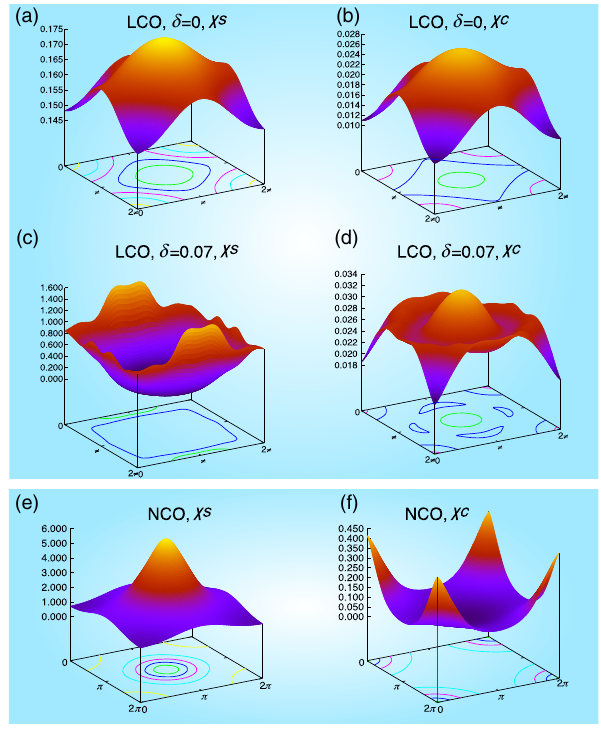
FIG. 2. Spin and charge fluctuations: static spin fluctuations X s ð k; ω ¼ 0 Þ for(a)pristineLCO,(c)distortedLCO( δ ¼ 0 . 07 Å), and (e) Nd 2 CuO 4 (NCO). Static charge fluctuations X c ð k; ω ¼ 0 Þ for(b)pristine LCO, (d)distortedLCO( δ ¼ 0 . 07